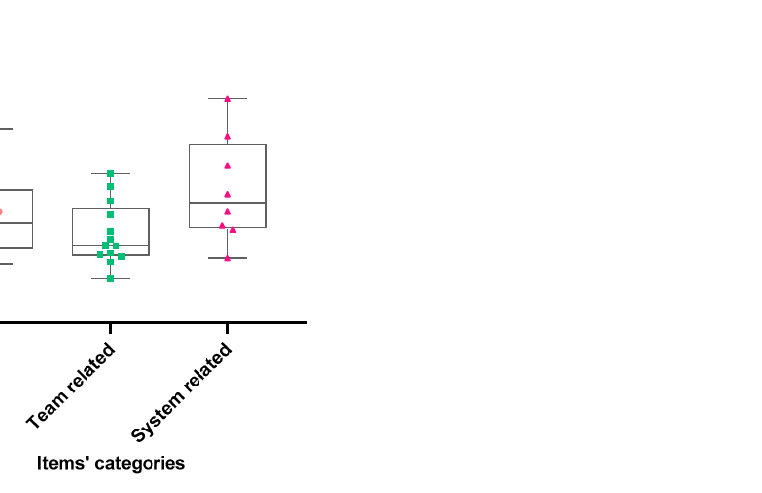
Figure 2. Box plot for distribution of average values for items’ means in patient-related, team-related, and system-related causes of moral distress in our cohort of ICU nurses.